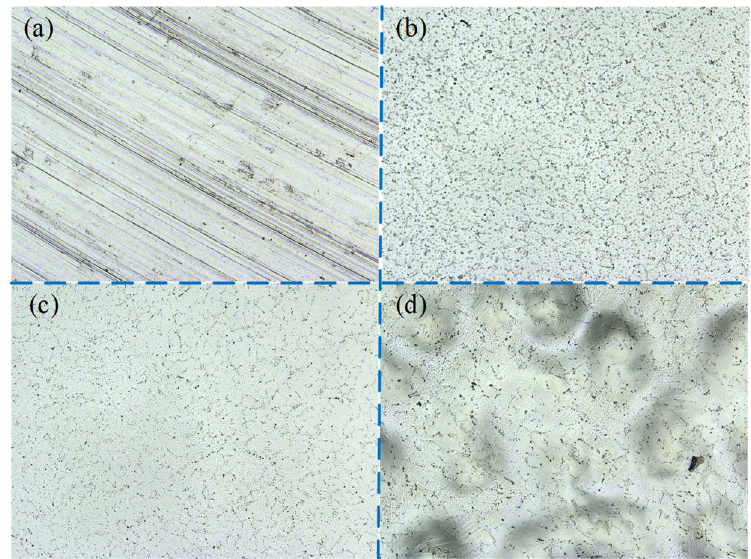
Figure 6. Surface morphology of electrochemical polishing: ( a ) 200 m/min milled specimen, ( b ) 1 A/cm 2 , ( c ) 3 A/cm 2 and ( d ) 6.5 A/cm 2 .